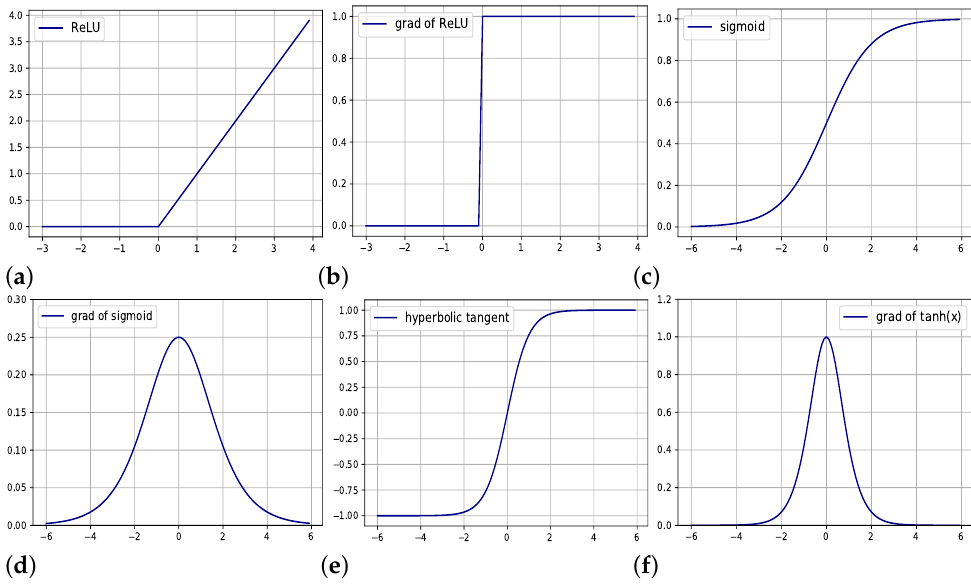
Figure A1. Some common activation functions: rectified linear unit (ReLu), sigmoid, and hyperbolic tangent (tanh). All of them are nonlinear functions. Left : the curves of the activation functions, and Right : their derivatives which are intensively used through backpropagation. ( a ) ReLu(x); ( b ) ReLu’(x); ( c ) sigmoid(x); ( d ) sigmoid’(x); ( e ) tanh(x); ( f )